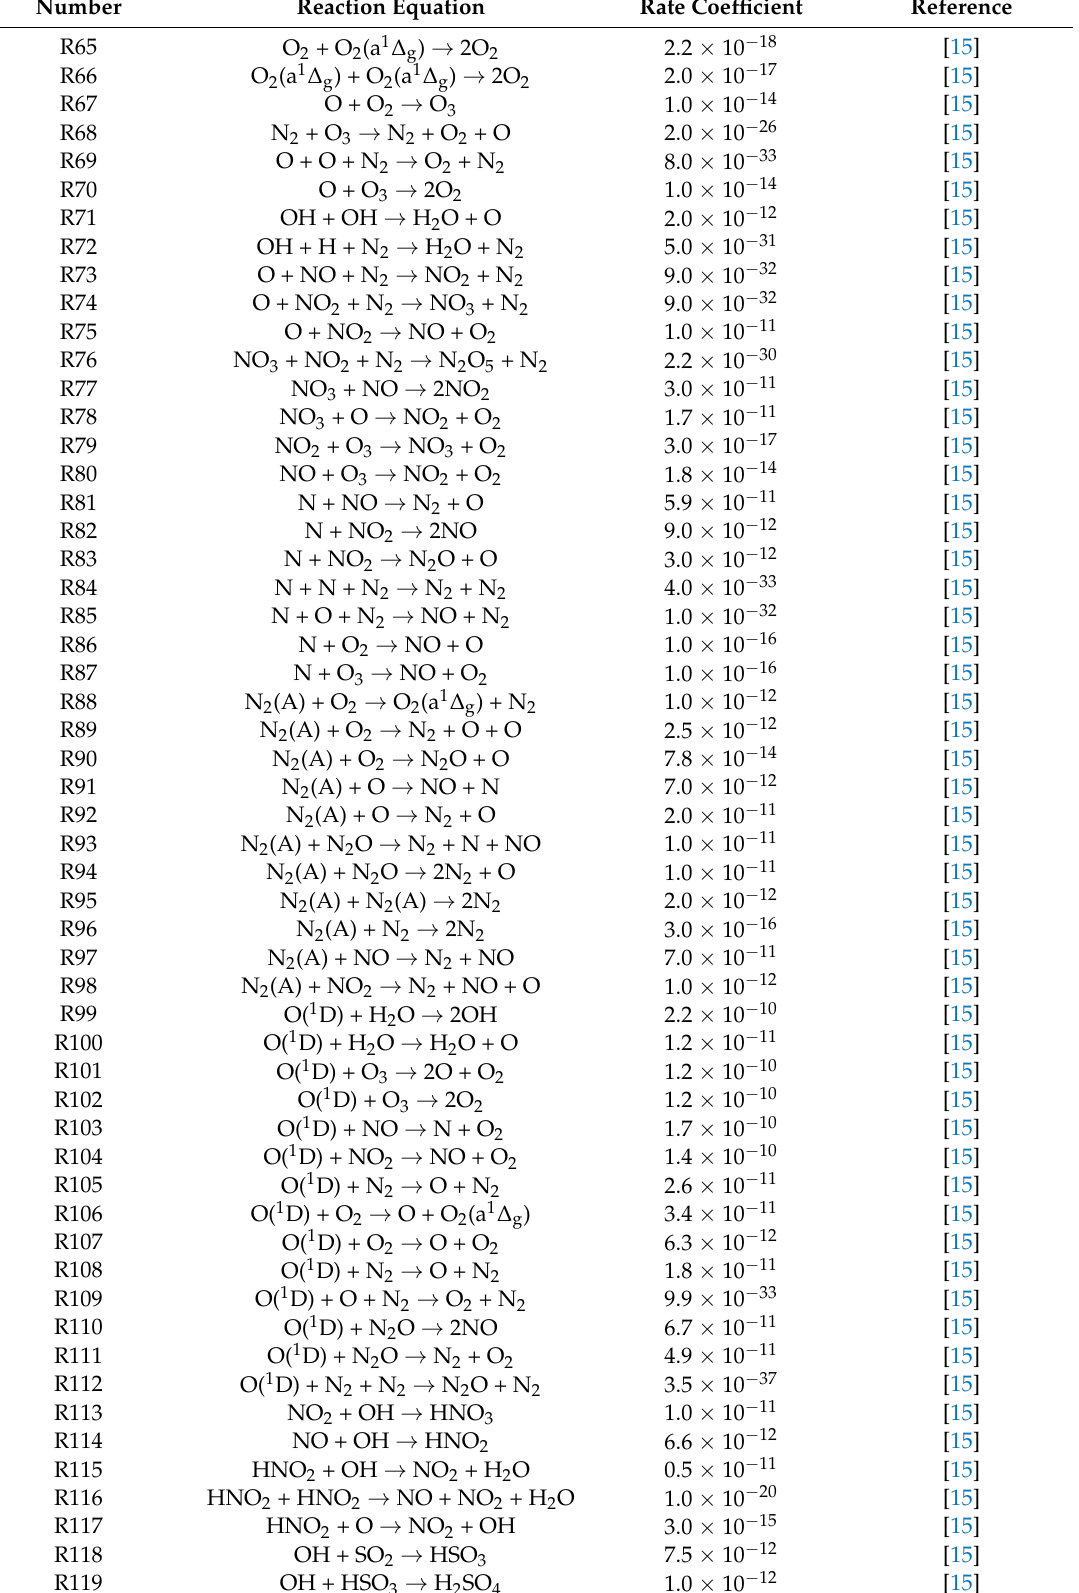
Table A2. Chemical kinetic